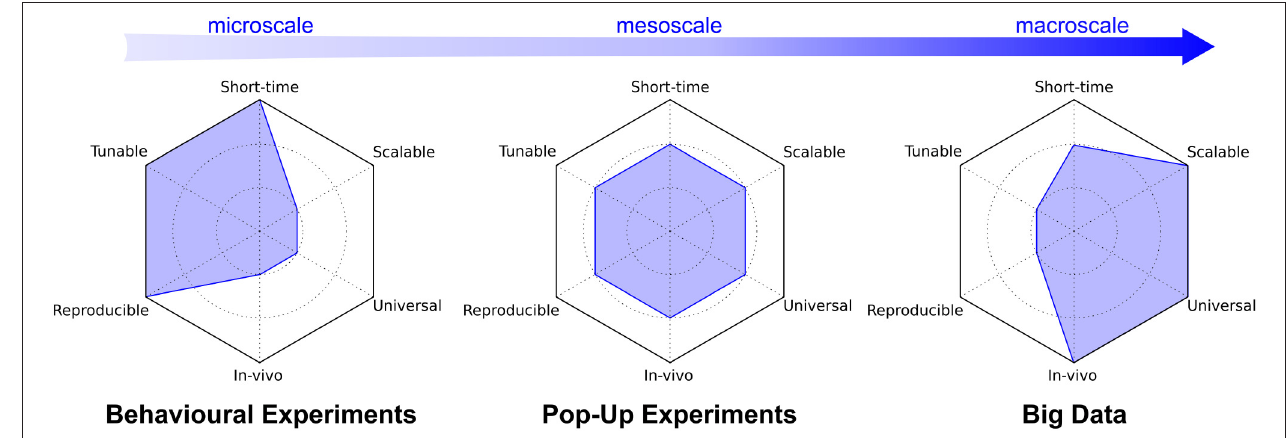
FIGURE 2 | Radar chart comparing seven characteristics of the pop-up experiment approach with behavioral experiment and big data research. The features are graded in three different degrees of intensity from low (smallest radius) to high (largest radius). “Short-time” describes the time required to run the experiment. “Scalable” qualifies how easy it is to scale up and increase the number of subjects in the experiment while preserving original design. “Universal” quantifies the generality of the statements produced by the experiments. “ In vivo ” measures how close the experimental set-up is to everyday situations or everyday life. “Reproducible” assesses the capacity to repeat the experiment under identical conditions. Finally, “Tunable” quantifies how flexible and versatile the conditions of the experimental design